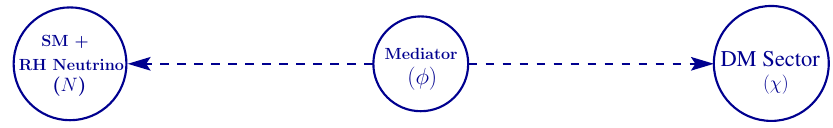
Figure 1 . Schematic representation for DM interaction with SM trough the scalar (cid:30) . Field